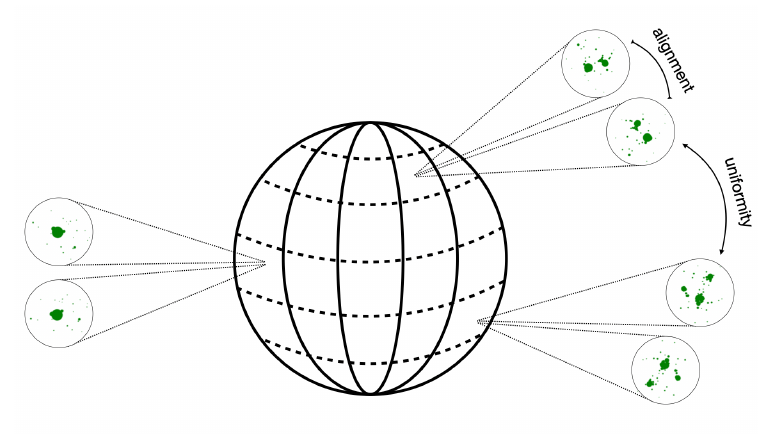
Figure 1: Illustration of the uniformity and alignment concepts behind the contrastive learning